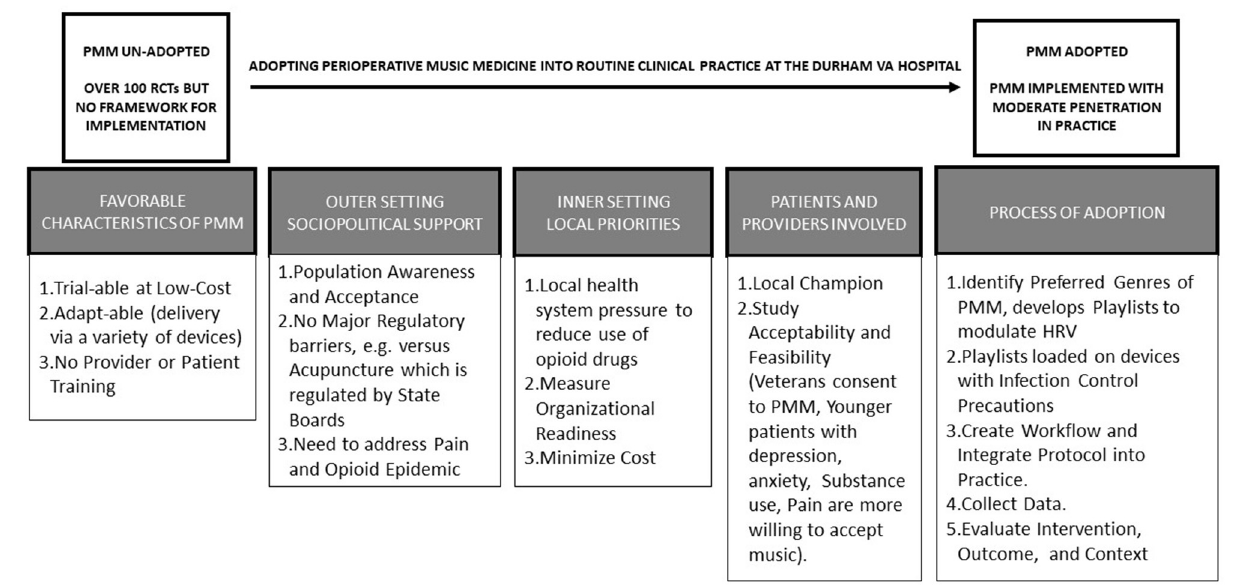
FIGURE 2 | The evidence to practice gap in implementing PMM practice. Schematic representation of the translational strategy from evidence to practice to implement the use PMM into routine clinical practice in orthopedic surgery at the Durham VA